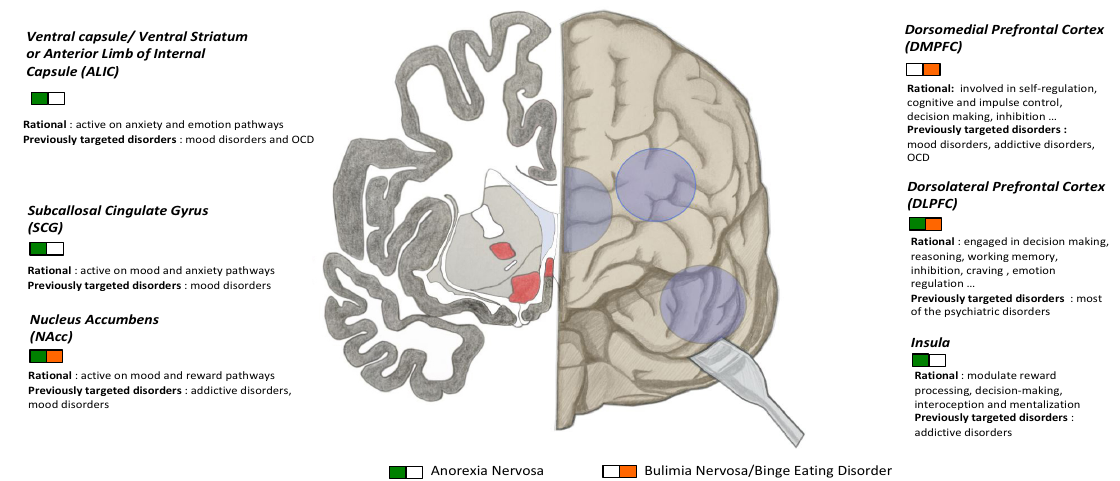
Figure 1. Overview of main neuromodulation targets in eating disorders. Schematic coronal section of right brain and front view of left brain. DBS: deep brain stimulation; rTMS: repetitive transcranial magnetic stimulation; tDCS: transcranial direct current stimulation; OCD: obsessive-compulsive disorder.